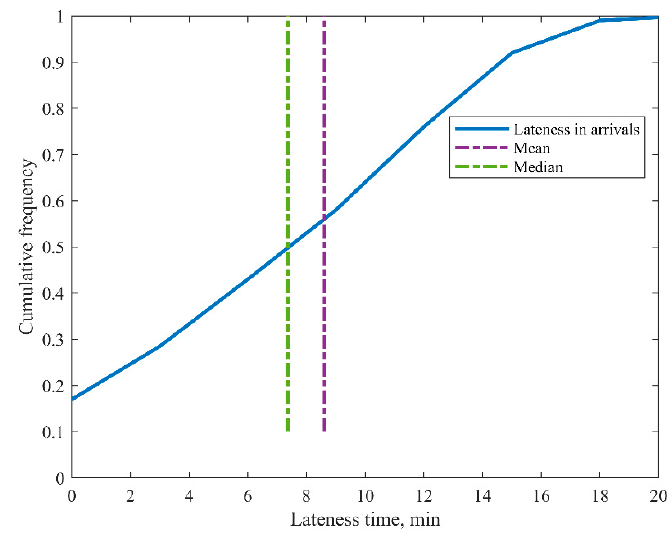
Figure A4. Arrival latency distribution.